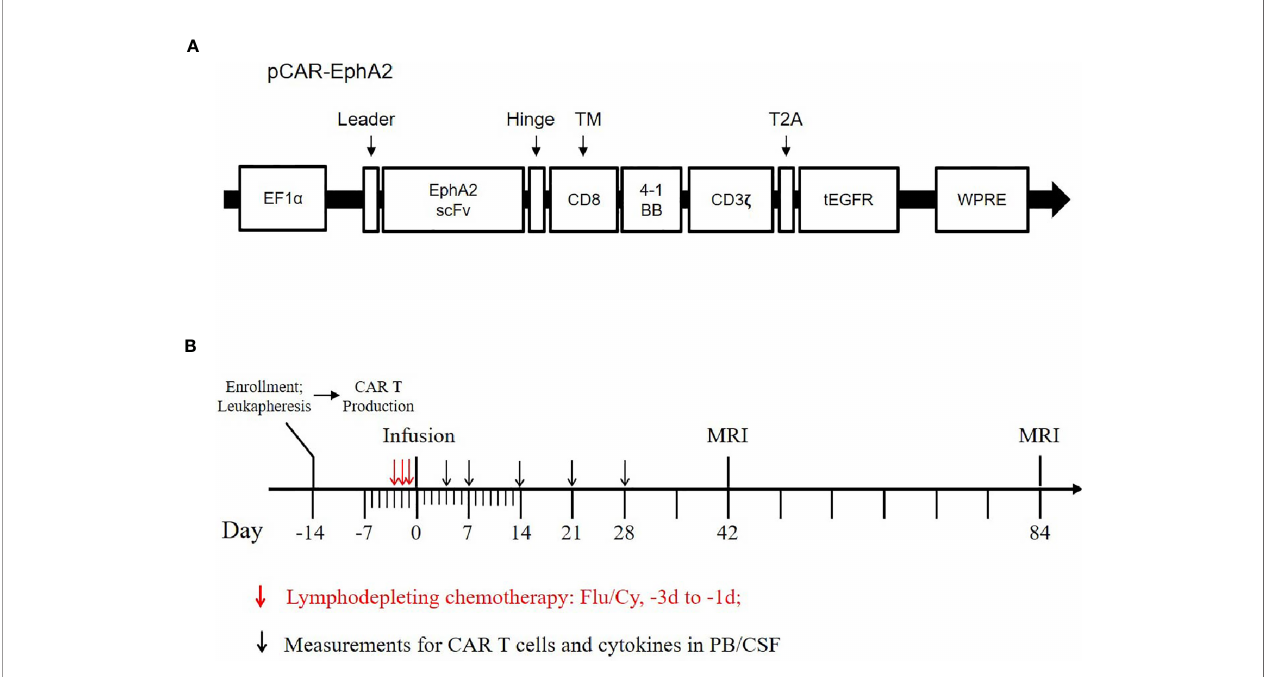
FIGURE 1 | Schema of EphA2-CAR vector and study protocol. (A) Sequence diagram of humanized anti-EphA2 CAR vector. EphA2 scFv, humanized anti-EphA2 single-chain fragment variable; tEGFR, truncated epidermal growth factor receptor. (B) Study protocol diagram. Flu, Fludarabine; Cy,